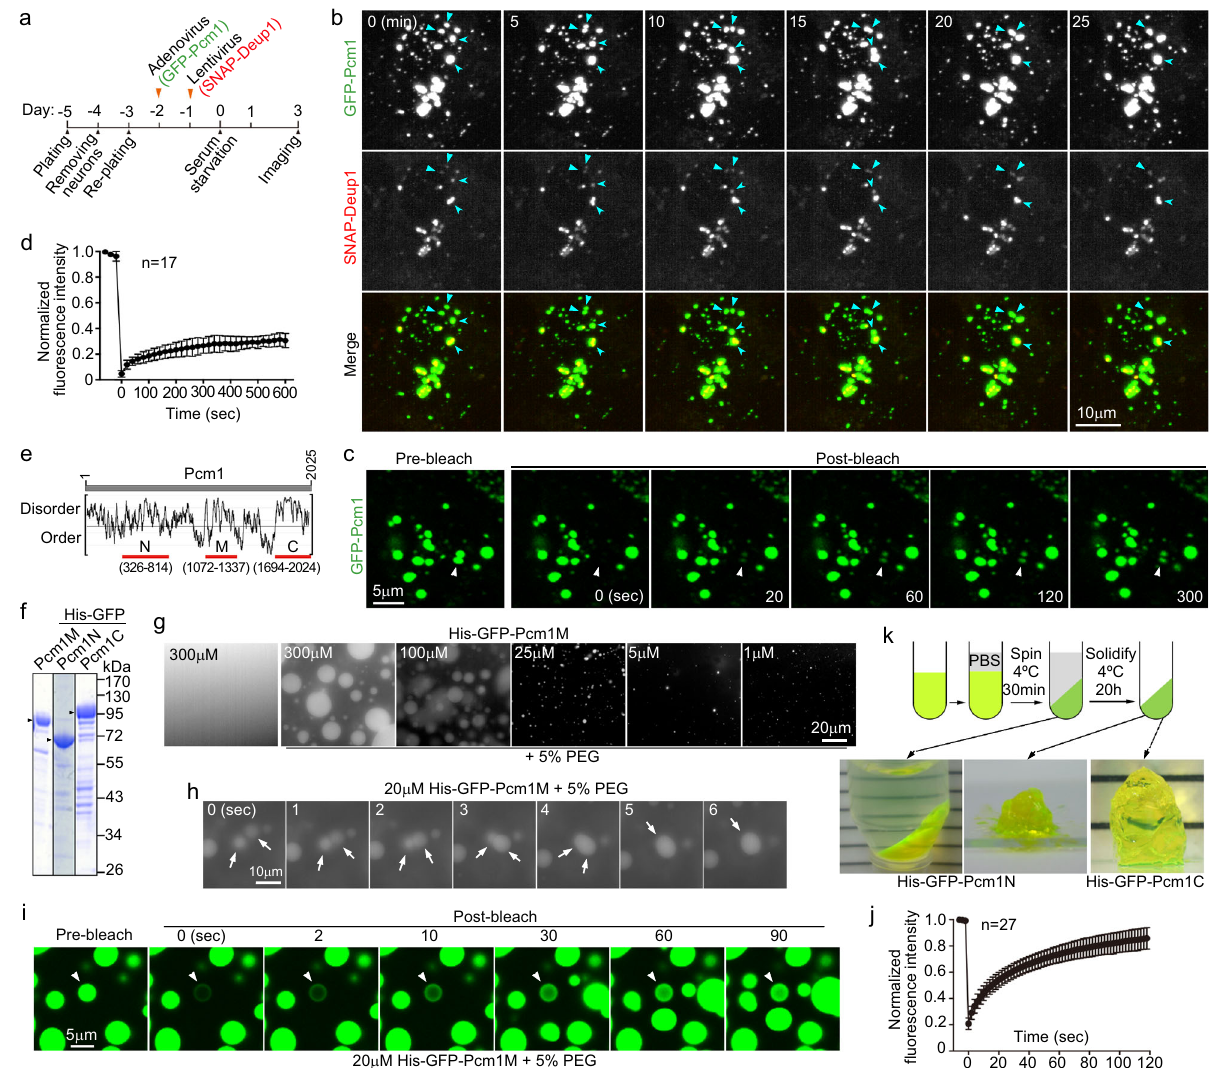
Fig. 7 FGMs tightly associate with deuterosomes and may form through Pcm1 phase separation. a Experimental scheme. Wild-type mEPC precursors were infected with adenovirus to express GFP-Pcm1 alone ( c ) or together with lentivirus to co-express SNAP-Deup1 ( b ). SNAP-Deup1 served as deuterosome marker and its expression, controlled by the Deup1 promoter, indicated cells undergoing the centriole ampli fi cation 26 . b FGM foci displayed liquid properties and associated with deuterosomes. Living mEPCs positive for GFP-Pcm1 and SNAP-Deup1 were imaged at 5-min intervals using a spinning disk confocal microscope. The image sequences show two fusion events of FGM foci (arrowheads). Note that the deuterosomes were associated and moved with FGM foci. 3D reconstruction was performed for the last frame to show spatial information (Supplementary Movie 6). More examples are presented in Supplementary Fig. 4. Experiment was performed once and multiple cells in different microscopic fi elds were live imaged. c , d FGM condensates displayed slow and limited exchanges of Pcm1 with the cytosol. mEPCs were infected to express GFP-Pcm1 as in a . GFP-positive condensates were photobleached, followed by live imaging ( c ). The fl uorescence recovery curve ( d ) was from 17 condensates. Two biologically independent experiments were performed. Data are presented as mean ± s.d. e , f Secondary structure prediction and expression of Pcm1 deletion mutants. Three fragments of Pcm1 containing predicted disordered regions ( e ) were expressed in E. coli as His-GFP-tagged fusion proteins and puri fi ed ( f ). g , h Pcm1M phase-separated into liquid droplets in the presence of PEG. Puri fi ed His-GFP-Pcm1M was diluted to the indicated concentrations with or without 5% PEG3350 and imaged after incubation at 25 °C for 2 min ( g ). The time-lapse images ( h ) show the fusion of two liquid droplets (arrows). Three biologically independent experiments were performed. i, j Liquid droplets of Pcm1M rapidly exchanged the protein with the milieu. Liquid droplets prepared as in h were photobleached, followed by time-lapse imaging ( i ). The arrowhead points to the representative droplet before and after the photobleaching. The fl uorescence recovery curve ( j ) was from 27 droplets. Data are presented as mean ± s.d. k Pcm1N and Pcm1C phase-separated into hydrogels. Hundred micromolar of soluble His-GFP-tagged Pcm1N or Pcm1C were topped with PBS and spun for 30 min and photographed against a white striped background to show the transparency of the pellets. After a further incubation for 20 h, the sticky pellets solidi fi ed into transparent hydrogels. Source data are provided in the Source data fi